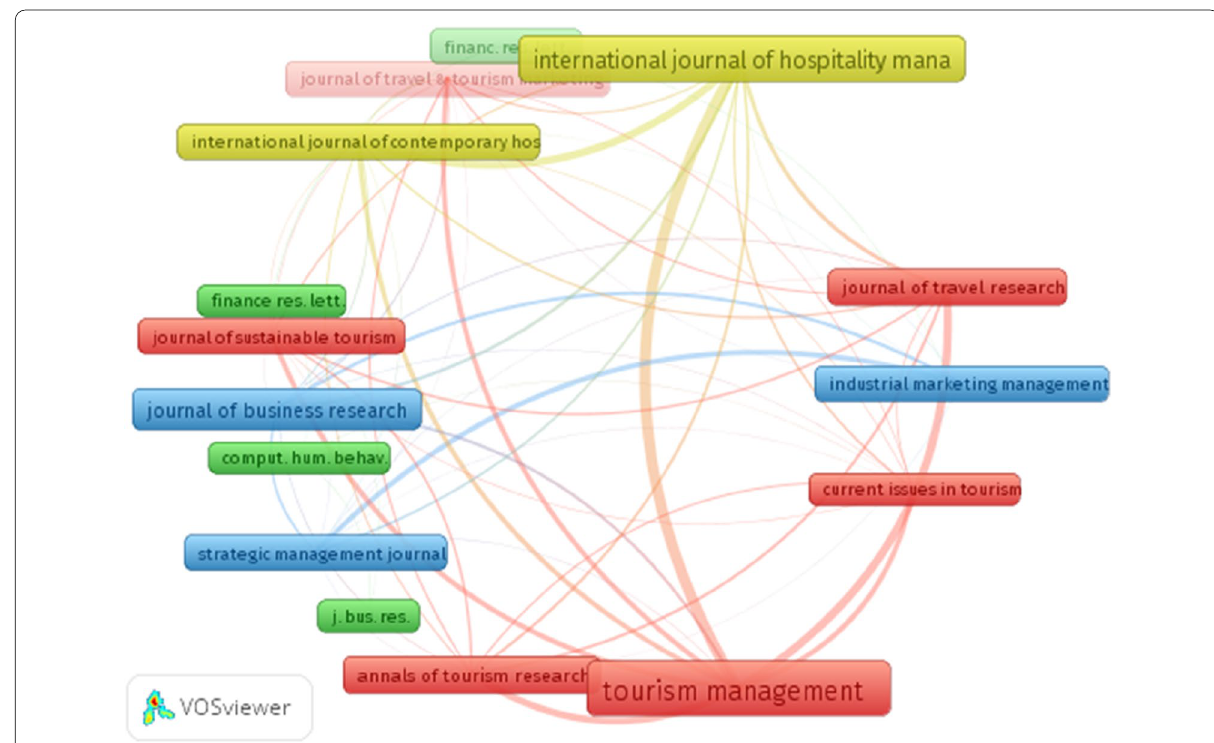
Fig. 4 Network visualization of the largest connected sets of cited sources by